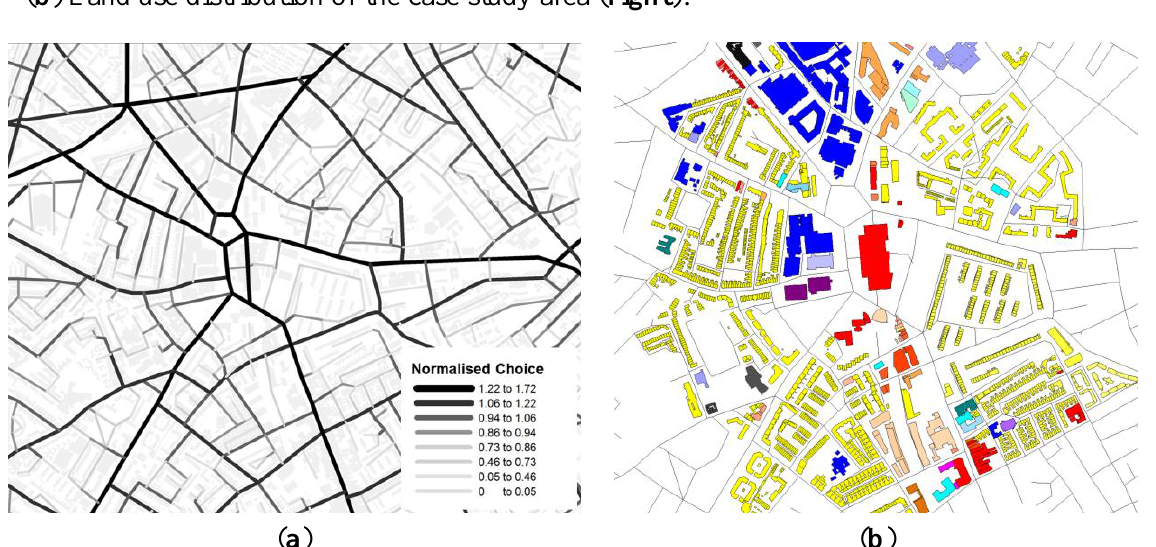
Figure 6. ( a ) Space syntax normalised angular choice of the case study area ( left ); ( b ) Land use distribution of the case study area ( right